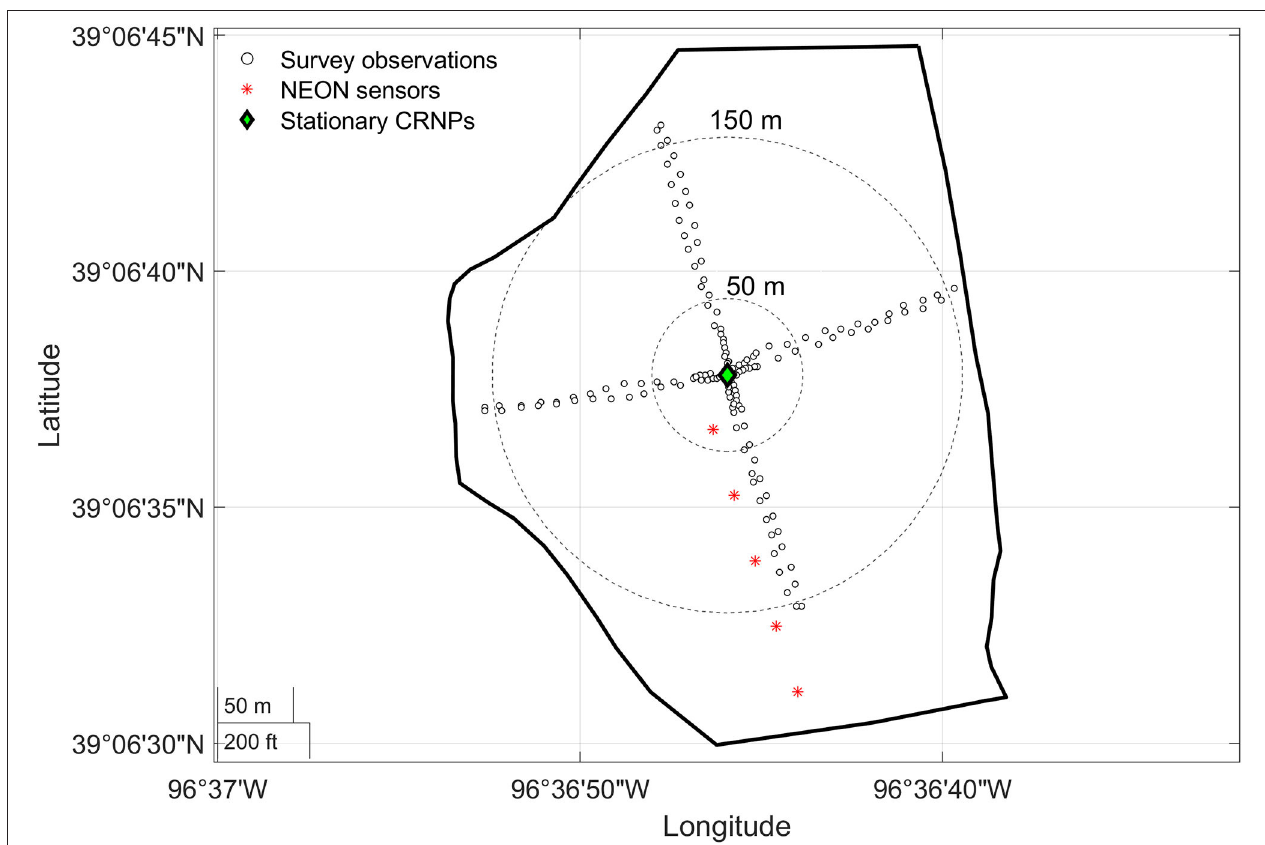
FIGURE 2 | Map of the field located in the Konza Prairie Biological Station showing the location of the stationary cosmic-ray neutron probes (CRNPs) (for clarity, a single marker was used to denote both CRNPs located only 3.5m apart), the five profile sensors of NEON KONA site, and the soil moisture observations ( n collected using a hand-held soil water reflectometer (Hydrosense II, Campbell Scientific) during the field survey on 21 May 2020. Approximately, 56% of the observations were within a 50m radius of the